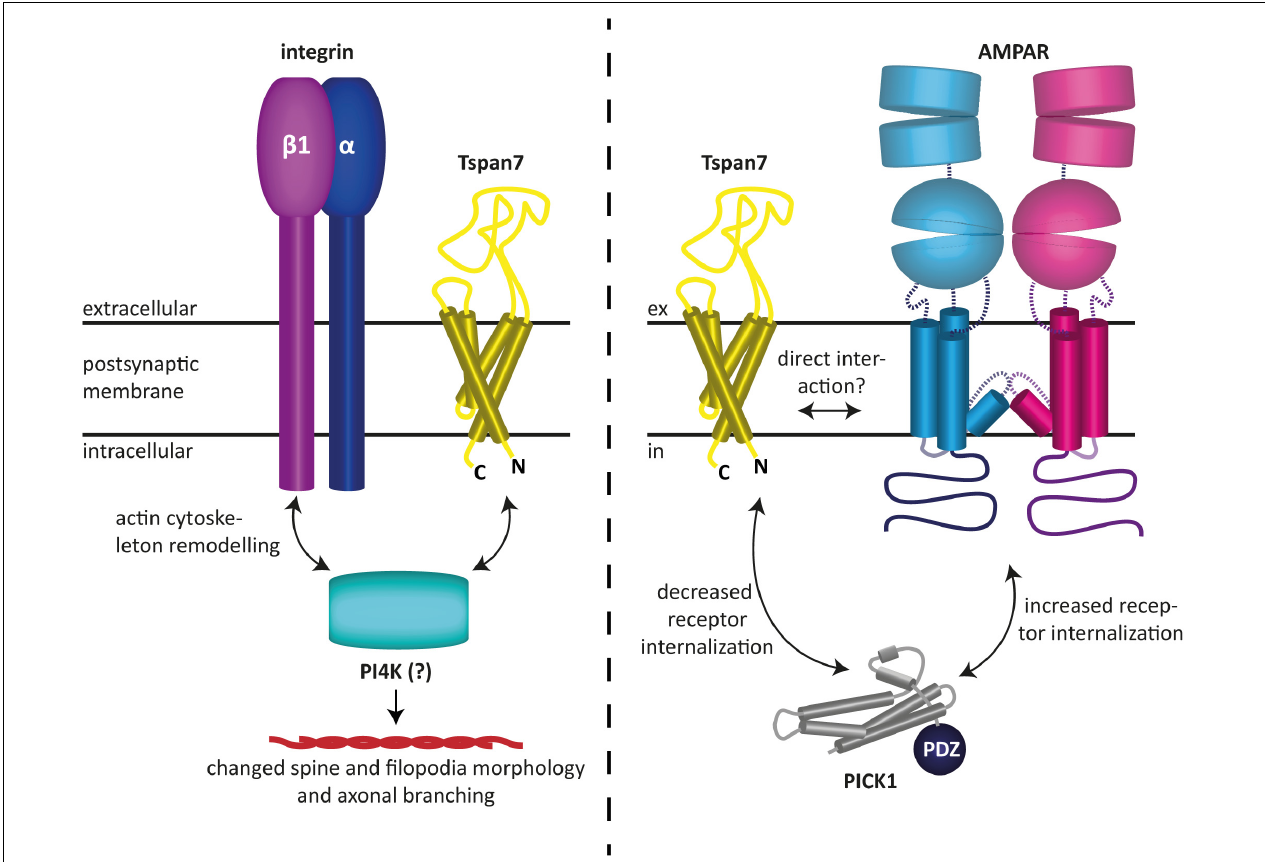
FIGURE 3 | Reported functions of Tspan7 in neurons. (Left) Tspan7 influences neuronal morphogenesis by regulating filopodia density and dendritic spine morphology. This is presumably mediated by interactions with integrin β 1 and/or PI4K and ultimately results in remodeling of the actin cytoskeleton (Bassani et al., 2012). (Right) Tspan7 regulates synaptic function at glutamatergic synapses. Interaction of Tspan7 with PICK1 attenuates the internalization of AMPARs, which is typically mediated by the interaction of the latter with PICK1 (Perez et al., 2001). This subsequently leads to an increased availability of AMPARs at the postsynaptic membrane and thus to an enhanced excitability of the postsynaptic neuron. In this process, Tspan7 interacts with PICK1 via its C-terminus (Bassani et al., 2012). The figures are based on the illustrations of Bassani and Passafaro (2012) and Perot and Ménager